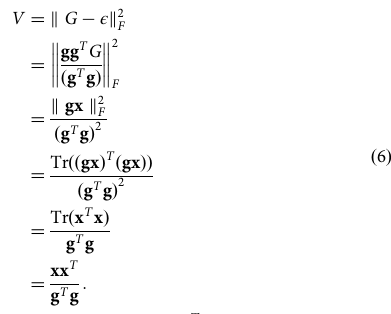
Algorithmic pipelines for single-cell epigenomic data,